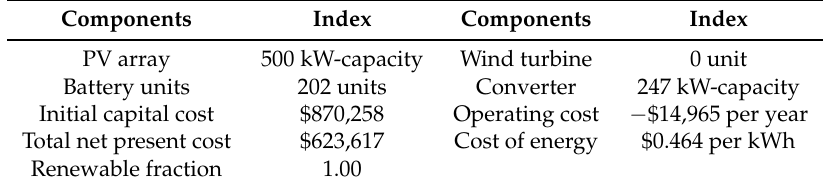
Table 4. Summary of the suggested configuration from the simulation results for SEMS.